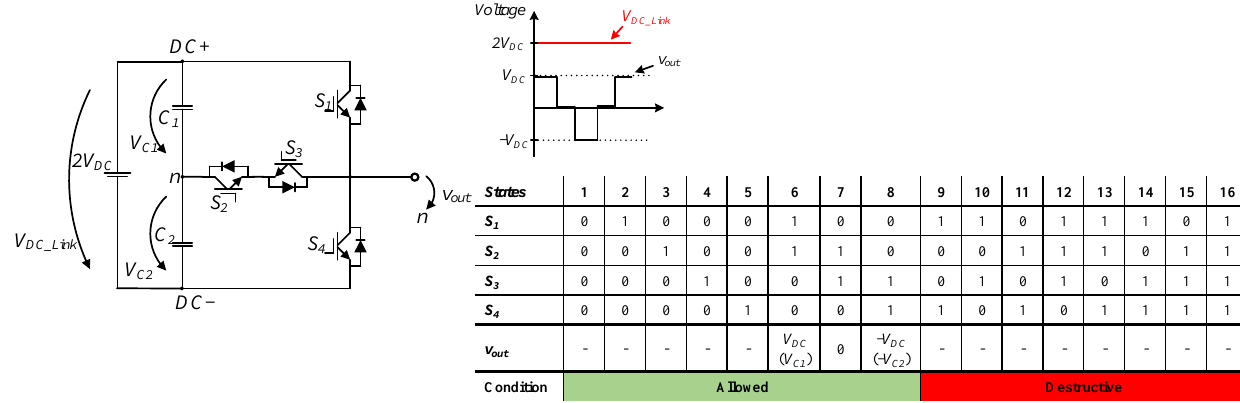
Figure 8. T-NPC topology and operation principle.